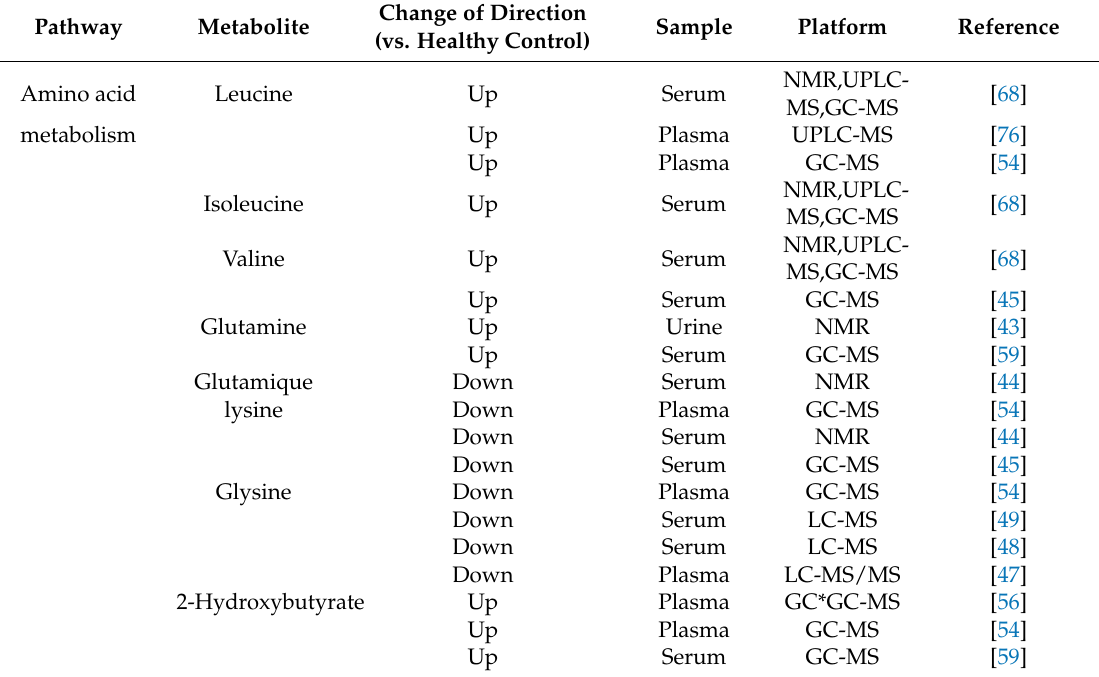
Table 2. List of altered metabolic pathways in T2DM